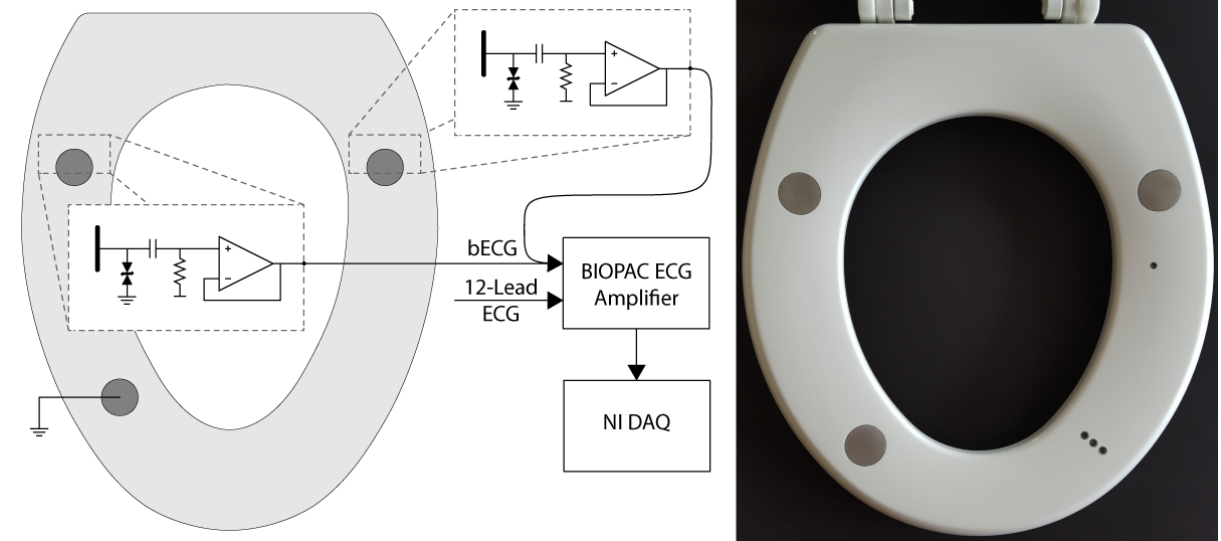
Figure 1. Stainless-steel electrodes are integrated into the seat and are connected directly to the integrated ECG analog front-end. The output of each front-end is low-impedance, allowing for a low-noise connection to the differential ECG amplifier inside of the BIOPAC MP150 system (left). The resulting full-scale ECG signal is acquired on a NI CompactRIO DAQ. For the HF subject study, all instrumentation and data acquisition circuitry are integrated into the toilet seat (right). DAQ: data acquisition system; ECG: electrocardiogram; bECG: buttocks ECG; NI: National Instruments; HF: heart